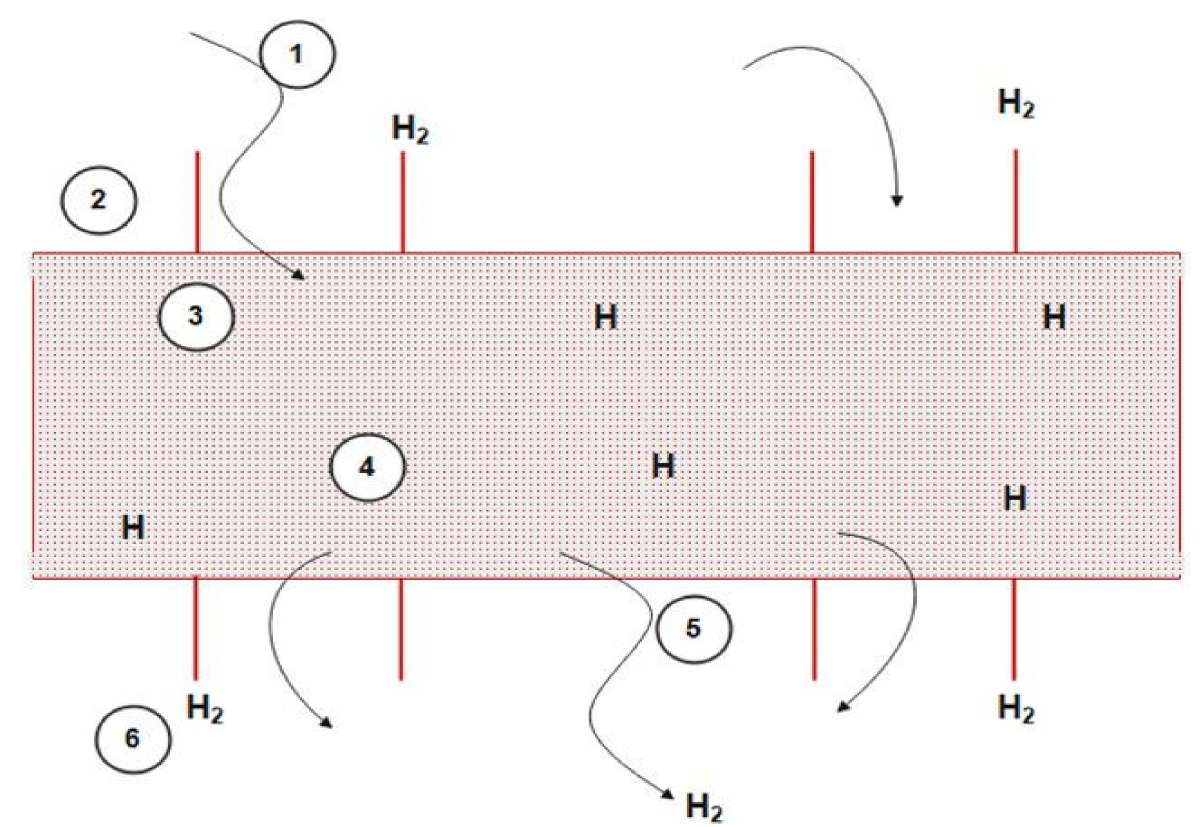
Figure 3. Hydrogen permeation from